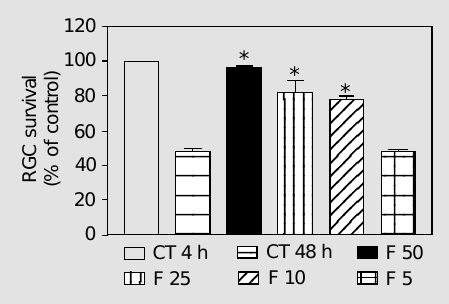
o l ) tr on Table 1. The effect of 50 µM forskolin on ganglion cell survival at different plating densities.